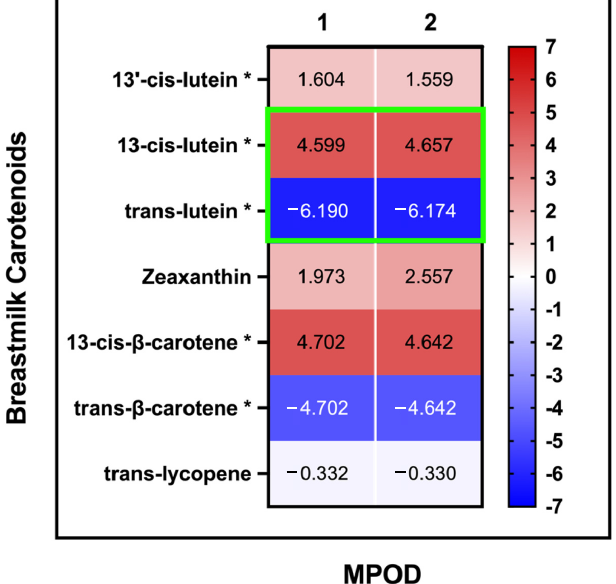
Figure 3. MPOD and breastmilk carotenoids: association of MPOD measurements with carotenoids in breastmilk: ( 1 ) no covariates ( 2 ) with maternal age, BMI, and daysPP as covariates (the slope ( β value) for each linear association is displayed in each cell). Significant assocation values are highlighted with green outline for 13-cis-lutein and trans-lutein. * For these variables, the total concentration of the carotenoids was included as covariates.